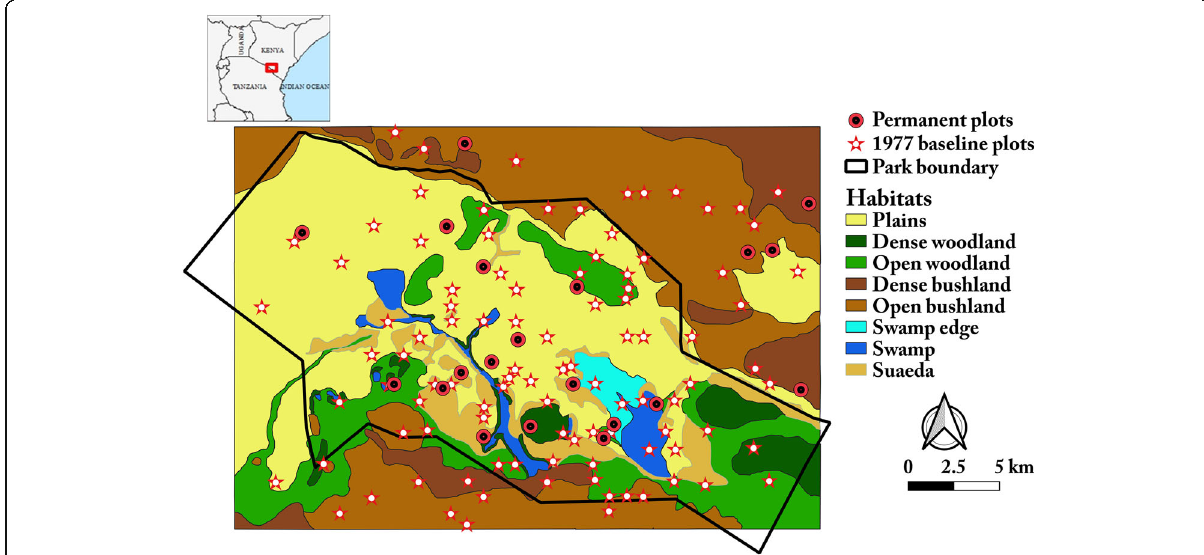
Fig. 1 Major habitats amalgamated into eight habitats from 29 vegetation zones defined in the 1967 baseline and subsequent surveys. The distribution of the 101 randomized plots in the 1977 species composition survey and the 20 subplots monitored every 4 to 6 weeks are shown. The permanent vegetation plots selected from the randomized set and measured monthly are distinguished by